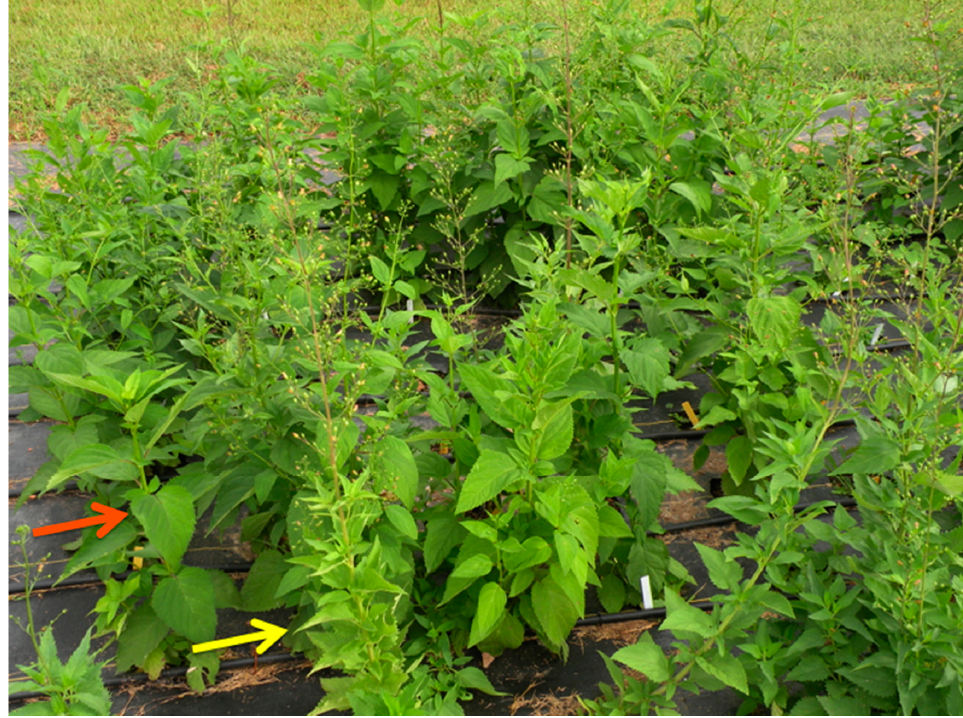
Figure 1. Morphological and phenological differences between S. lanceolata (yellow arrow) and S. marilandica (orange arrow) plants grown in the field.